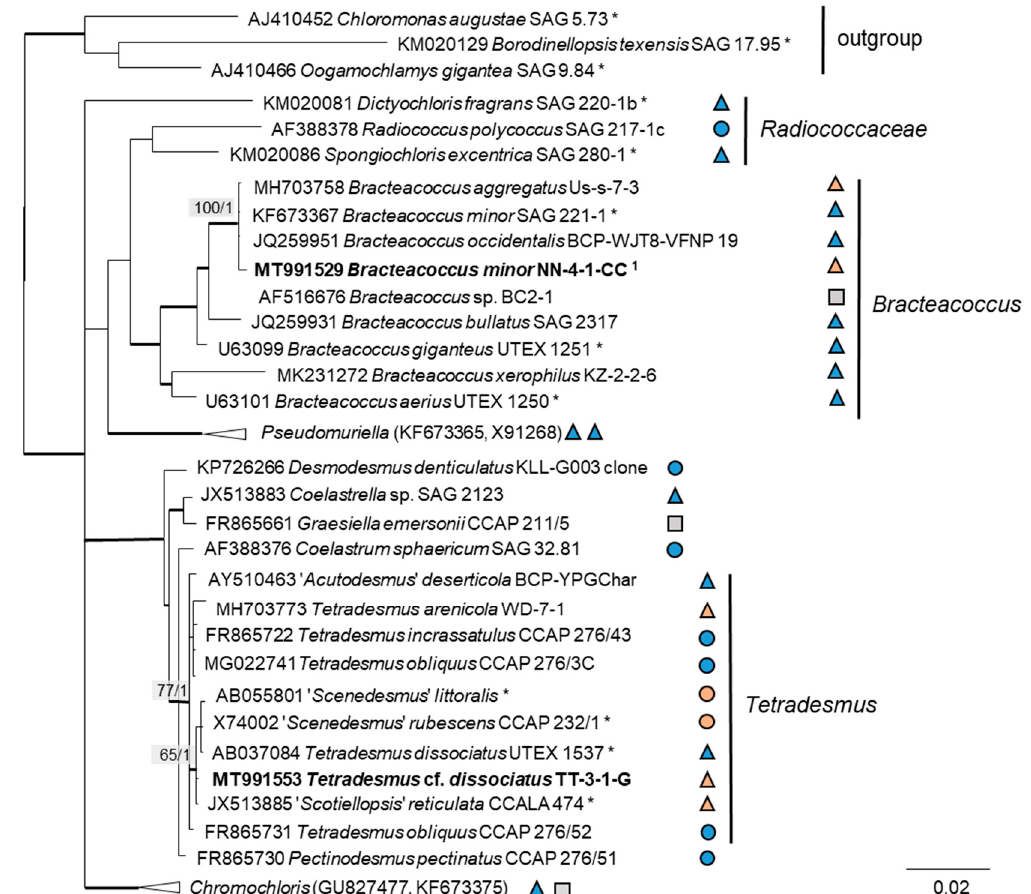
Figure 2. Molecular phylogeny of the Chlamydomonadales based on small subunit ribosomal ribonucleic acid (SSU rRNA) gene sequencing. The phylogenetic tree was calculated by the Bayesian method, including posterior probabilities (PP) with additional maximum likelihood bootstrap values (BP); branches are supported by both methods in bold (BP > 60% and PP > 0.9). Authentic strains were marked with an asterisk, original strains from this study in bold. Habitats of the strains were classified according to habitat type ( Δ terrestrial = absence of permanent water, o aquatic = presence of water, and □ unknown) and saline ( ); nonsaline ( ); and unknown ( ) habitats. Figure 3. Molecular phylogeny of the Sphaeropleales based on SSU rRNA gene sequencing. The phylogenetic tree was calculated by the Bayesian method, including posterior probabilities (PP) with additional maximum likelihood bootstrap values (BP); branches are supported by both methods in bold (BP > 60% and PP > 0.9). Authentic strains were marked with an asterisk, original strains from this study in bold. Habitats of the strains were classified according to habitat type ( Δ terrestrial = absence of permanent water, o aquatic = presence of water, and □ unknown) and saline ( ); nonsaline ( ); and unknown ( ) habitats. 1 Identical to Bracteacoccus minor NN-4-1-CC (MT991529), NN-4-1-H (MT991530), NN-4-1-D2 (MT968390), TTF-1-1-M (MT991533), TTF-2-1-A (MT991534), and TTF-2-1-J (MT991535). Figure 4. Molecular phylogeny of the Ulvophyceae based on SSU rRNA gene sequencing. The phylogenetic tree was calculated by the Bayesian method, including posterior probabilities (PP) with additional maximum likelihood bootstrap values (BP); branches are supported by both methods in bold (BP > 60% and PP > 0.9). Authentic strains were marked with an asterisk, original strains from this study in bold. Habitats of the strains were classified according to habitat type ( Δ terrestrial = absence of permanent water, o aquatic = presence of water, ◊ phycobiontic or endophytic, and □ unknown) and saline ( ); nonsaline ( ), and unknown ( ) habitats. 1 Identical to Halochlorococcum sp. TT-4-1-M (MT968405), TT-4-1-O (MT968406), NN-4-1-Q (MT968401), NN-4-1-S (MT968402), and NN-4-1-T (MT968403). Figure 5. Molecular phylogeny of the Trebouxiophyceae based on SSU rRNA gene sequencing. The phylogenetic tree was calculated by the Bayesian method, including posterior probabilities (PP) with additional maximum likelihood bootstrap values (BP); branches are supported by both methods in bold (BP > 60% and PP > 0.9). Authentic strains were marked with an asterisk, original strains from this study in bold. Habitats of the strains were classified according to habitat type ( Δ terrestrial = absence of permanent water, o aquatic = presence of water, ◊ phycobiontic or endophytic, and □ unknown) and saline ( ); nonsaline ( ); other extremes ( e.g., acidity); and unknown ( ) habitats. 1 Identical to Watanabea sp. NN-1-2-X1B (MT968415) and 2 identical to Pseudostichococcus monallantoides SY-1-2-P (MT991549), WT-3-1-A (MW074294), WT-3-1-H (MT991551), and WT-3-1-P1 (MT991552). Figure 6. Molecular phylogeny of the cyanobacteria based on SSU rRNA gene sequencing. The phylogenetic tree was calculated by the Bayesian method, including posterior probabilities (PP) with additional maximum likelihood bootstrap values (BP); branches are supported by both methods in bold (BP > 60% and PP > 0.9). Authentic strains were marked with an asterisk, original strains from this study in bold. Habitats of the strains were classified according to habitat type ( Δ terrestrial = absence of permanent water, o aquatic = presence of water, ◊ phycobiontic or endophytic, and □ unknown) and saline (